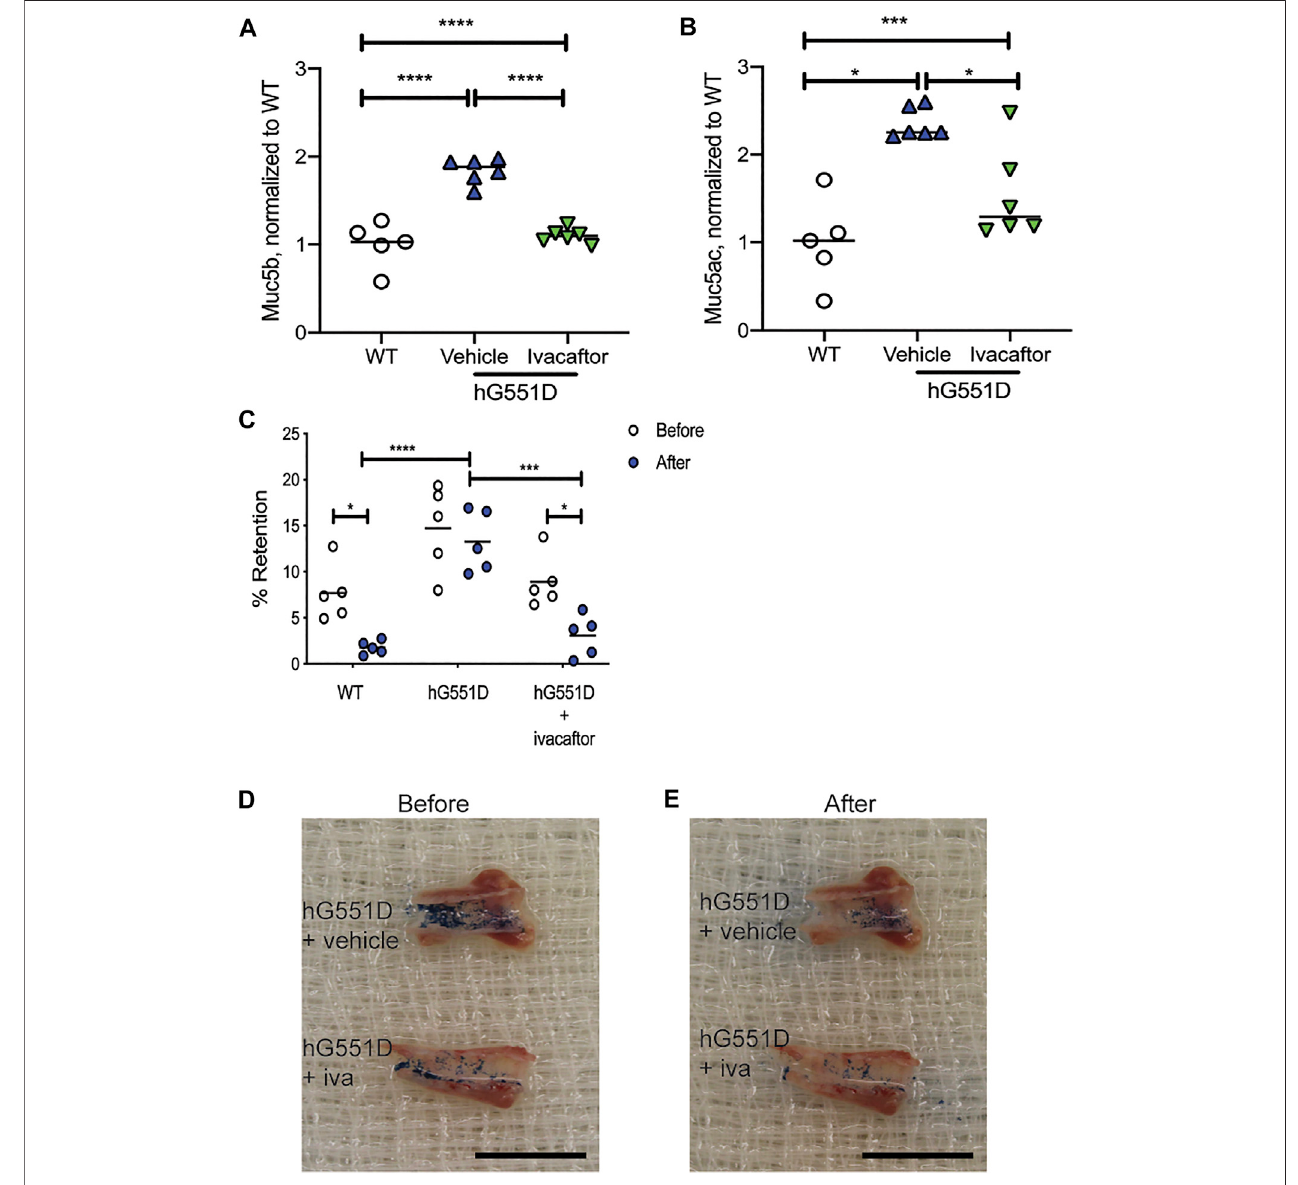
FIGURE5| Ivacaftor normalizesmucincontentoftheBALFinhG551Drats.WTandhG551Dratsat6 monthsofageunderwentbronchoalveolarlavage.hG551D rats were split into groups that received vehicle or ivacaftor therapy for 7 days. (A) Muc5b and (B) Muc5ac were detected in BALF following the treatment. (C) % Retention was calculated from before and after washing on tracheae collected from WT, hG551D, and hG551D + ivacaftor. Representative images from hG551D and hG551D + ivacaftor (D) before wash and (E) after wash. Black scale bar = 1.5 cm. Lines on the graphs represent the mean. Data were analyzed using one-way ANOVA with Dunnett ’ s post-test. * p < 0.05, *** p < 0.001, **** p < 0.0001.